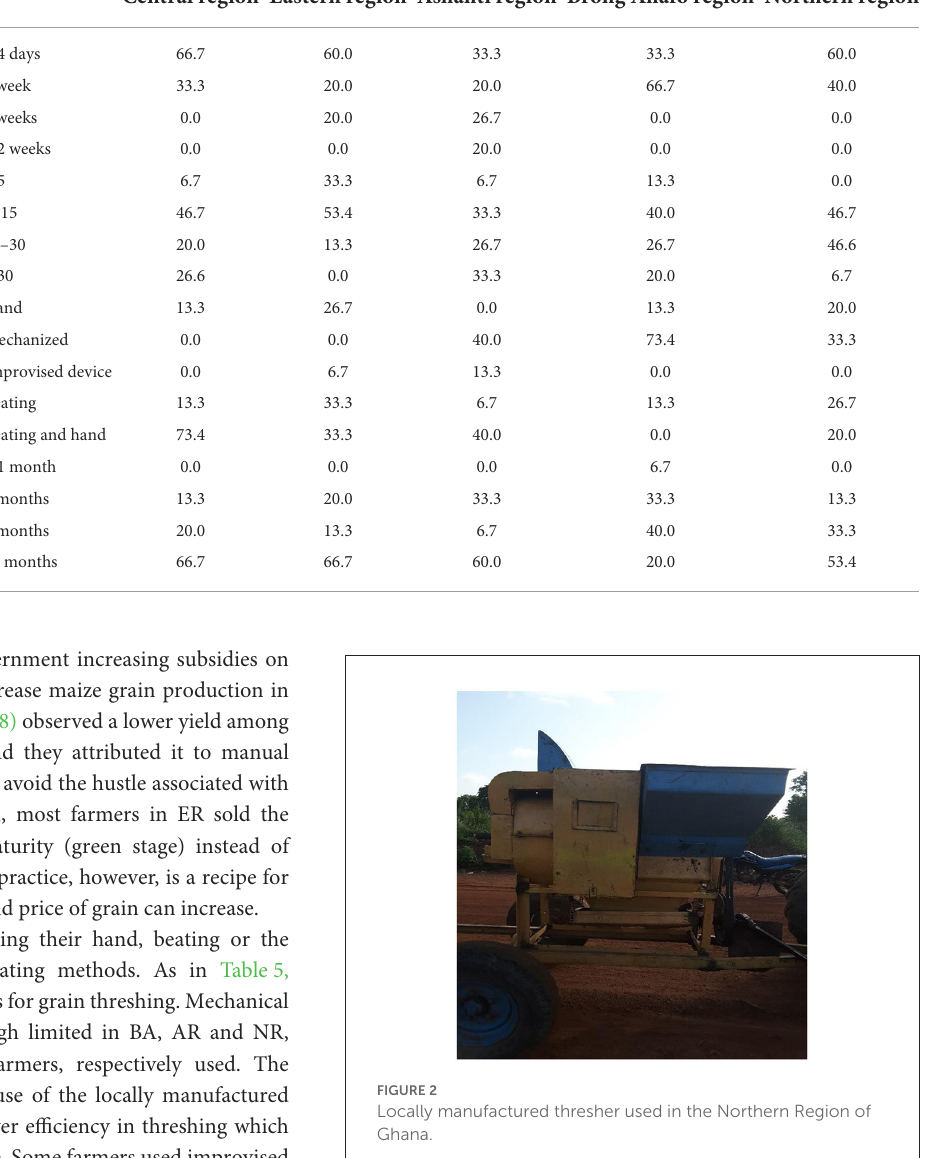
TABLE 5 Farmers’ experience in maize grain harvesting, threshing, and storage. Parameter Percentages